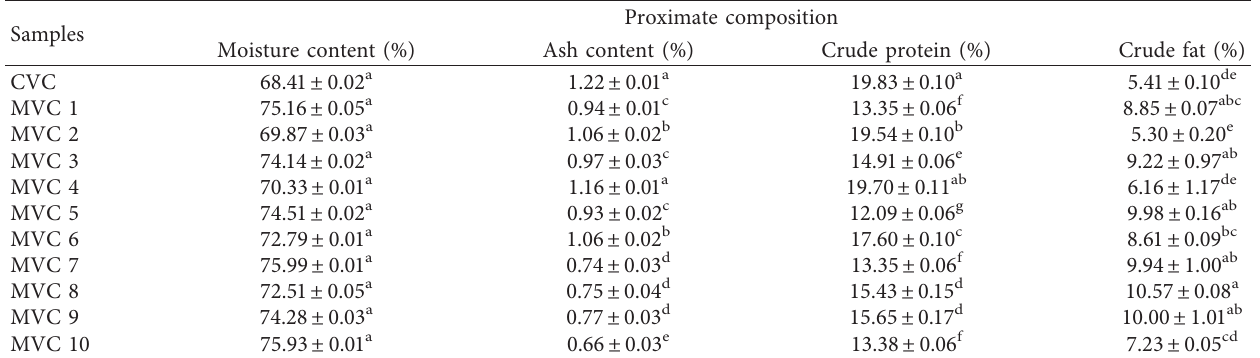
Table 1: Proximate composition of village chicken meat obtained from a genuine supplier and 10 different markets.